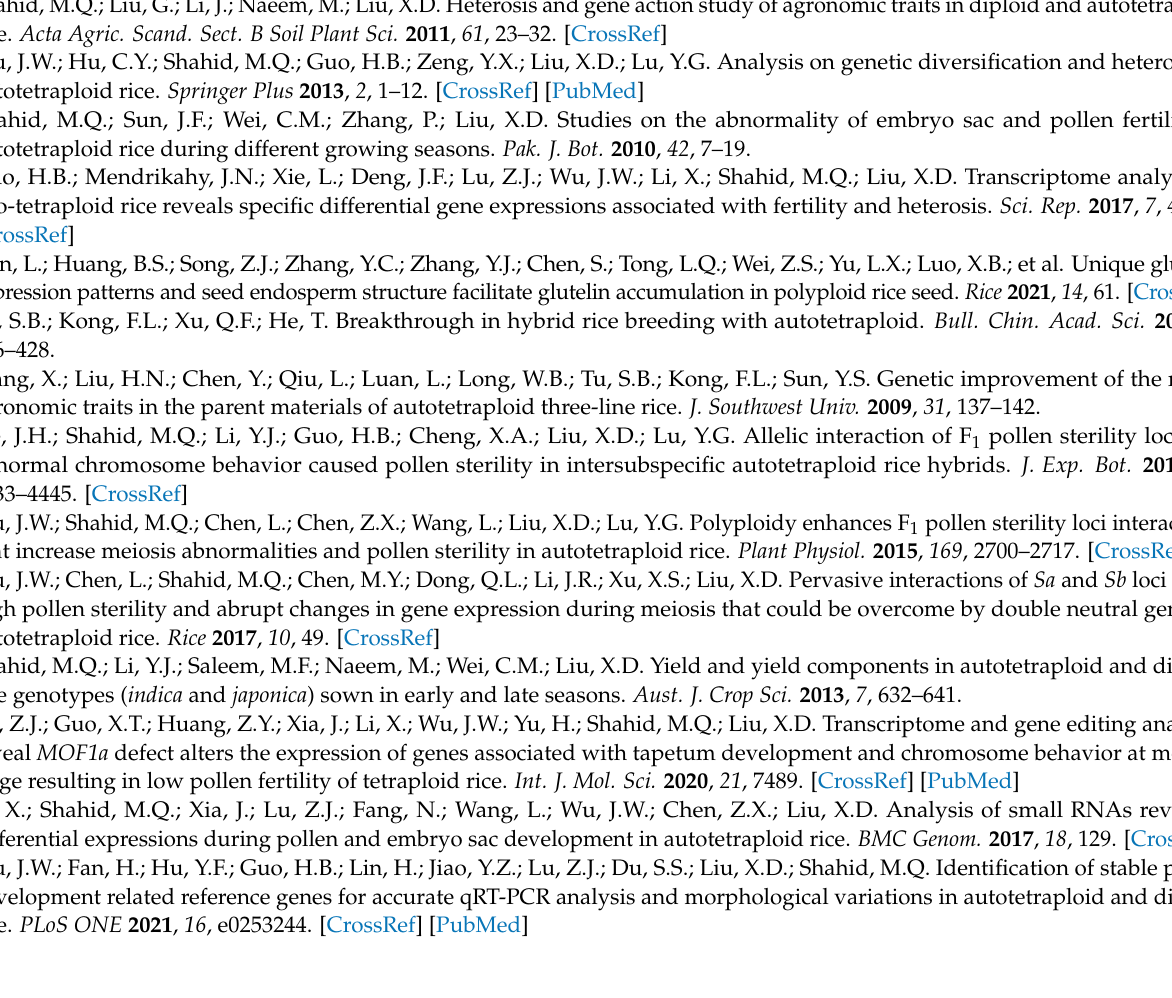
Table S2: Pollen fertility and seed setting of self-crossed TGMS lines at different temperatures; Table S3: The fertility and heading date of H2s and H3s mutants under different sowing dates; Table S4: Heterosis analysis of F 1 hybrid compared to the